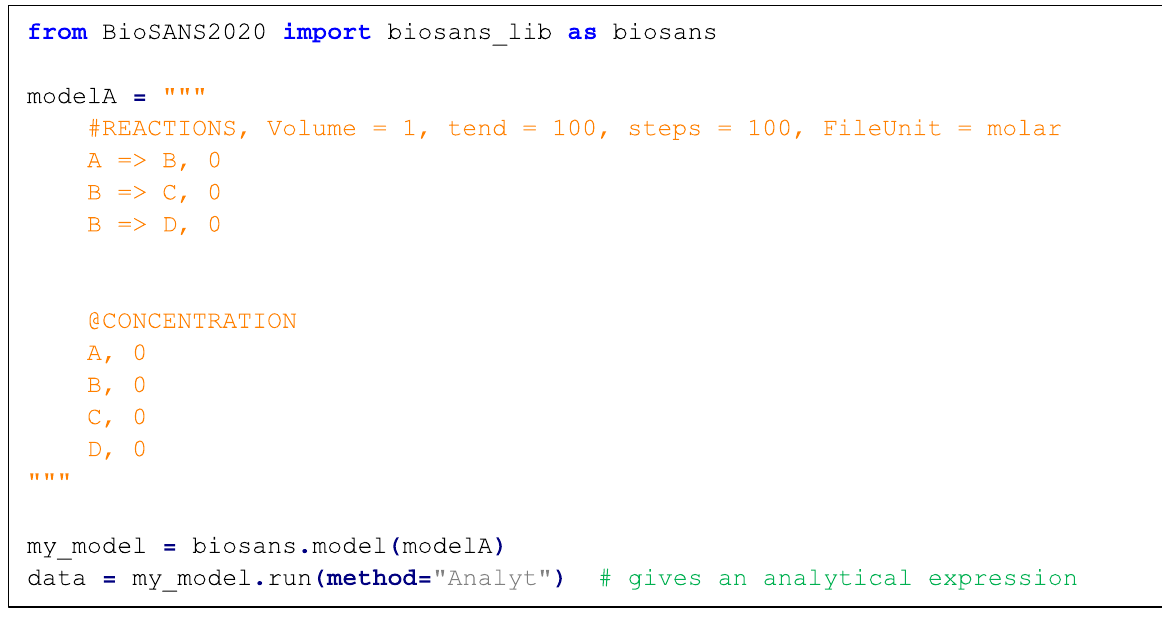
Fig 5. An example of the use of BioSANS as a python import or